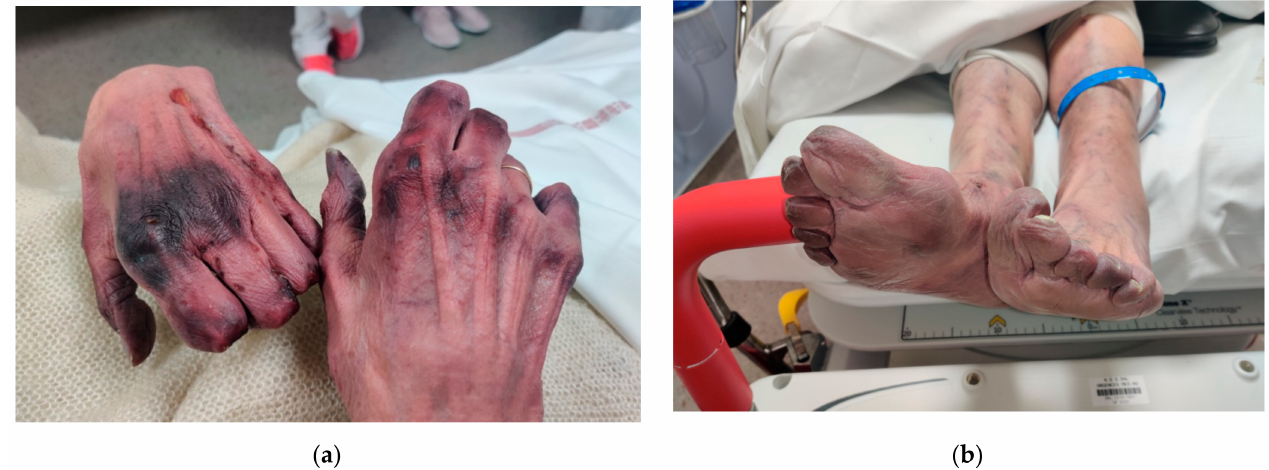
Figure 1. Upon admission at the emergency department (J0). ( a ) Hands, ( b ) Lower